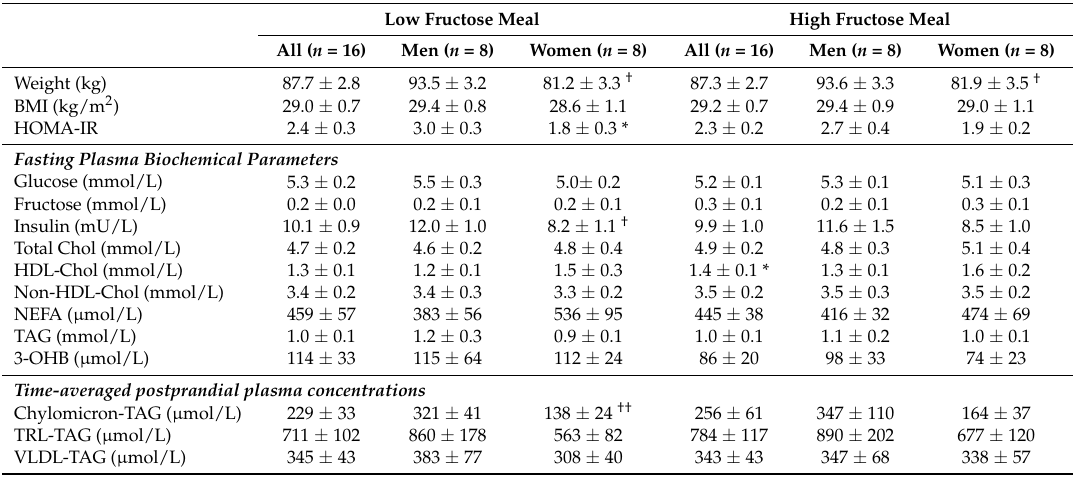
Table 2. Participant characteristics and biochemical variables on the low-fructose and high-fructose meal study